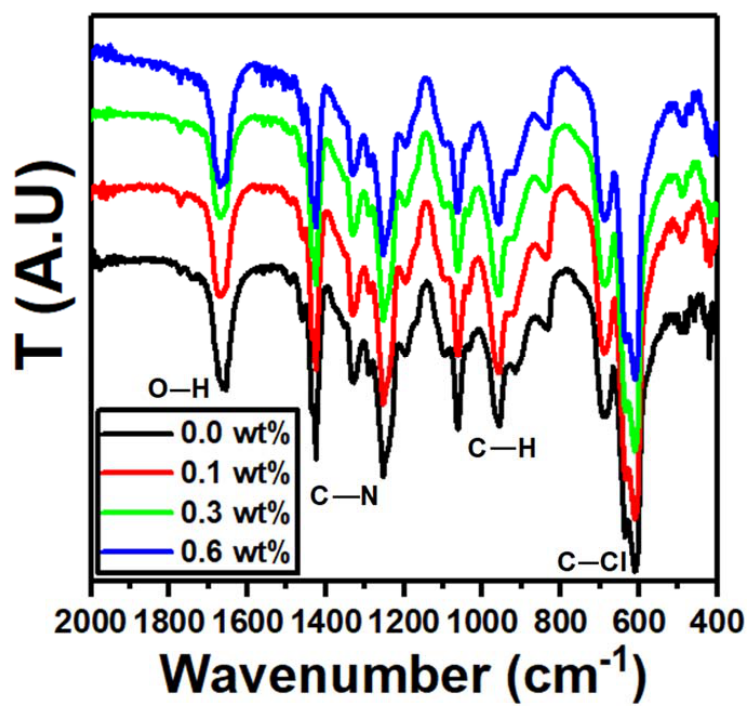
Polymers 2022 , 14 , x FOR PEER REVIEW Figure 3. FTIR spectra of nanocomposites PVC/PVP/Er 2 O 3 . Figure 3. FTIR spectra of nanocomposites PVC/PVP/Er 2 O 3 . The vibrations at 1462 and 1290 cm − 1 are generated because of C − N stretching and bending vibrations, while the C − Cl bond is responsible for the bands at 605 and 633 cm − 1 [27]. Er 2 O 3 has a metal ‐ oxygen bond (M − O) shown at 557 cm − 1 [29]. The Raman spectra of the nanocomposites at various Er 2 O 3 concentrations are shown in Figure 4. Stretching vibrations of the C − Cl bonds induced the strong peaks at 635 and 695 cm − 1 . Furthermore, the stretching vibration of C − H and CH 2 bonds generated the sharp peak at 2916 cm − 1 [30]. The intensity of the band at 635 cm − 1 of the PVC/PVP blend is increased upon doping with only 0.1 wt% of Er 2 O 3 . The intercalation of PVC/PVP/Er 2 O 3 was proven with this level of quenching, particularly in the C − Cl region where the asym ‐ metric stretching vibration of Er 2 O 3 is most noticeable.